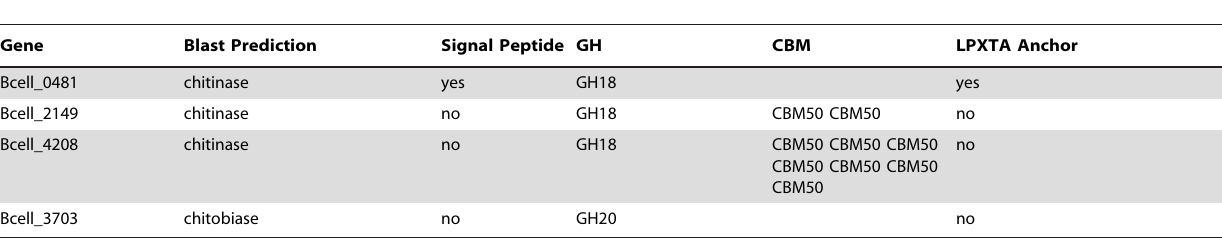
Table 9. Annotated Chitin-degrading Enzymes.